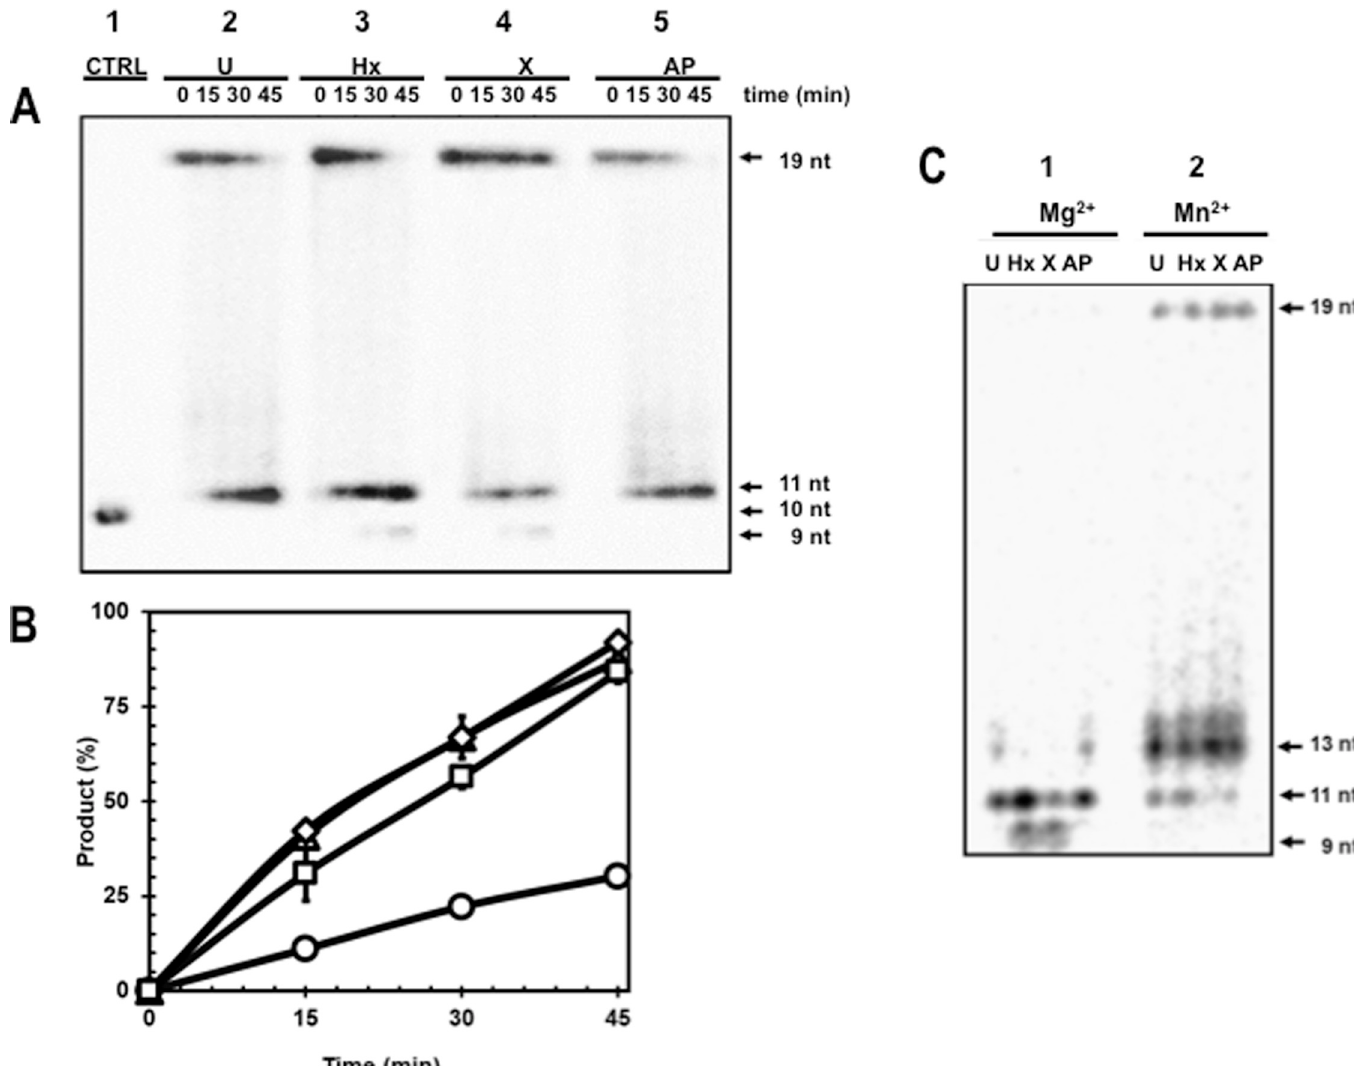
Fig 2. Differential processing of DNA lesions by Bs EndoV. (A) Ability of Bs EndoV to process different deaminated bases and AP-sites in ds-DNA. A [ 32 P]-labeled 19-mer-DNA (at 10 nM concentration) containing a U (column 2), a Hx (column 3), an X (column 4), or an AP-site (column 5) were annealed to their complementary non-radioactive oligonucleotide and incubated separately with 100 nM of Bs EndoV in presence of MgCl 2 as described in Methods, and samples were collected at indicated times. A control reaction (column 1) contained the labeled oligonucleotide with U incubated with commercial uracil-DNA glycosylase (Ung) and AP-endonuclease (Nfo) in order to estimate the size of the nicked products generated by Bs EndoV. All reactions were separated by denaturing electrophoresis, exposed and analyzed as described in Methods. (B) Densitometry analyses of the conversion of each substrate into product by Bs EndoV using radiolabeled ds-DNAs containing U ( Δ ), Hx ( ^ ), X ( � ) or an AP-site ( □ ). (C) Effects of the divalent ions Mg 2+ (column 1) and Mn 2+ (column 2) on the endonuclease activity of Bs EndoV on ds-DNAs containing deaminated bases or an AP site. U, uracil; H, hypoxanthine; X, xanthine and AP, apurinic/apirimidinic site.